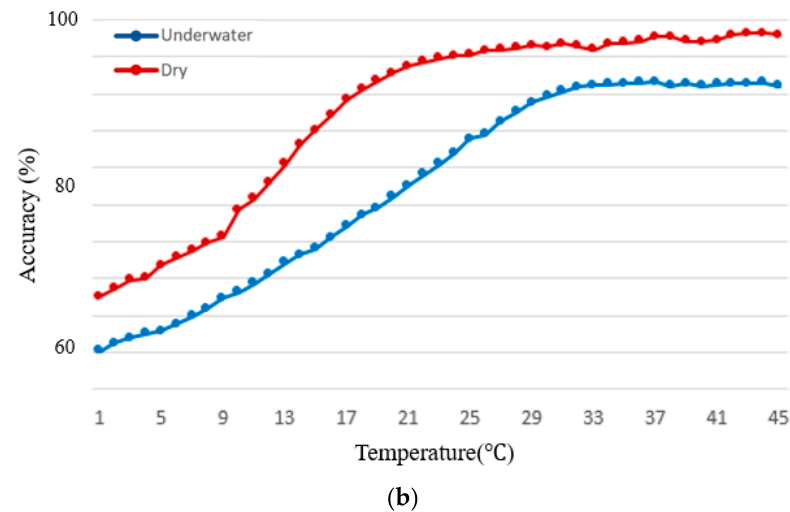
Figure 10. Signal amplitude and heart rate accuracy acquired from smartphone PPG signals for varying temperature in dry (red) and underwater (blue) environments. ( a ) signal amplitude, and ( b ) heart rate accuracy.